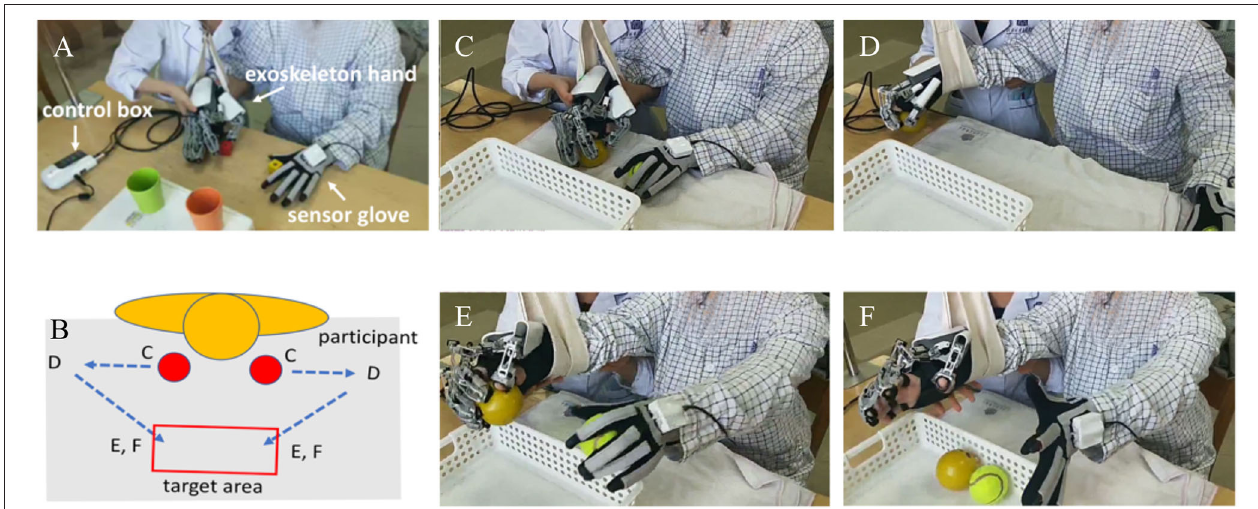
FIGURE 1 | (A) The exoskeleton robotic device and (B) the motor trace of robot-assisted bimanual therapy (RBMT) used in this study; the circle red was the initial point. (C–F) Demonstrated an example of the motor path of a ball gasping/releasing task according to the (B) .